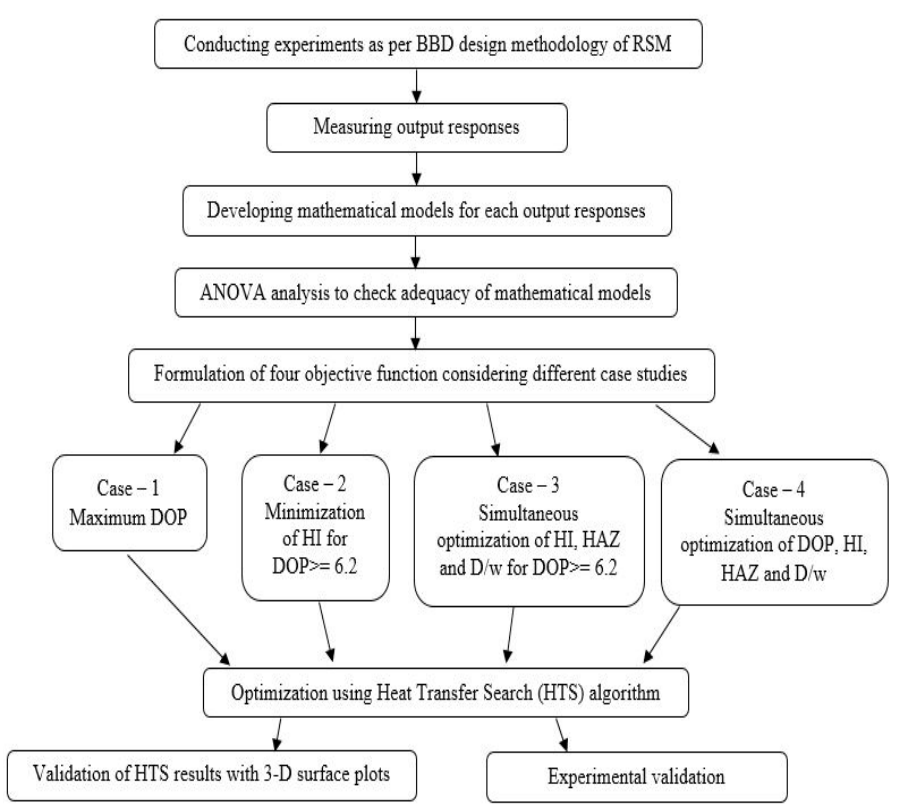
Figure 3. The optimization route followed in this